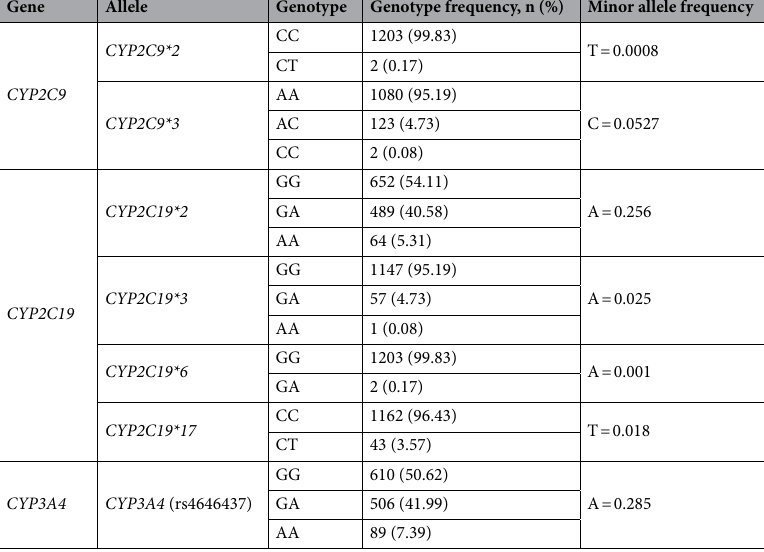
Table 4. In our sample of the Thai population, 89.46% possessed a wild-type CYP2C9 genotype while 10.54% possessed a mutated CYP2C9 genotype. There were 1078 subjects (89.46%) classified as CYP2C9 NM ( *1/*1 ), 125 subjects (10.37%) classified as CYP2C9 IM ( *1/*2 and *1/*3 ), and 2 subjects (0.17%) classified as CYP2C9 PM ( *3/*3 ). Regarding CYP2C19 , 48.22% possessed wild type CYP2C19 genotype while 51.78% possessed a mutated CYP2C19 genotype. There were 581 subjects (48.22%) classified as CYP2C19 NM ( *1/*1 ), 518 subjects (42.98%)